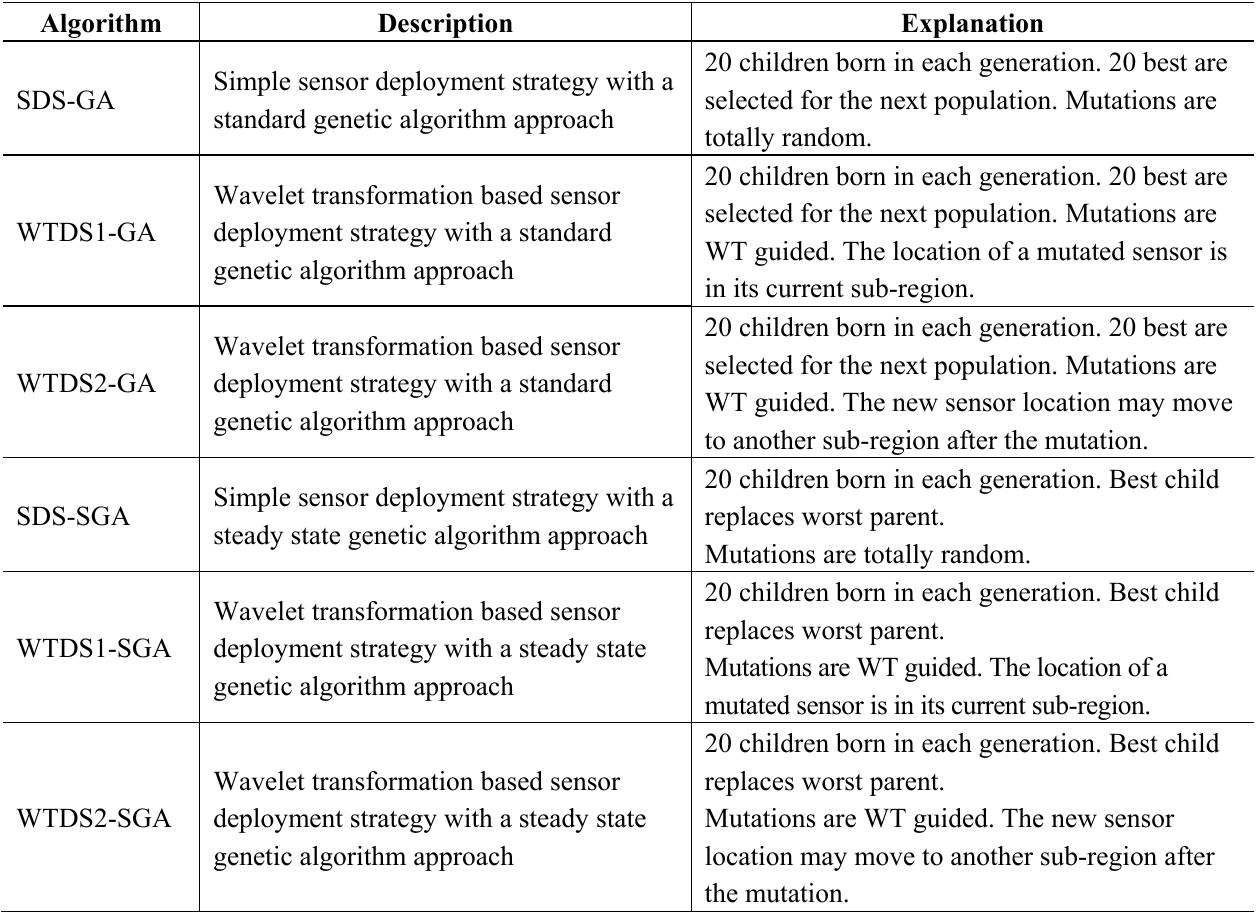
Table 2. Evaluated GA